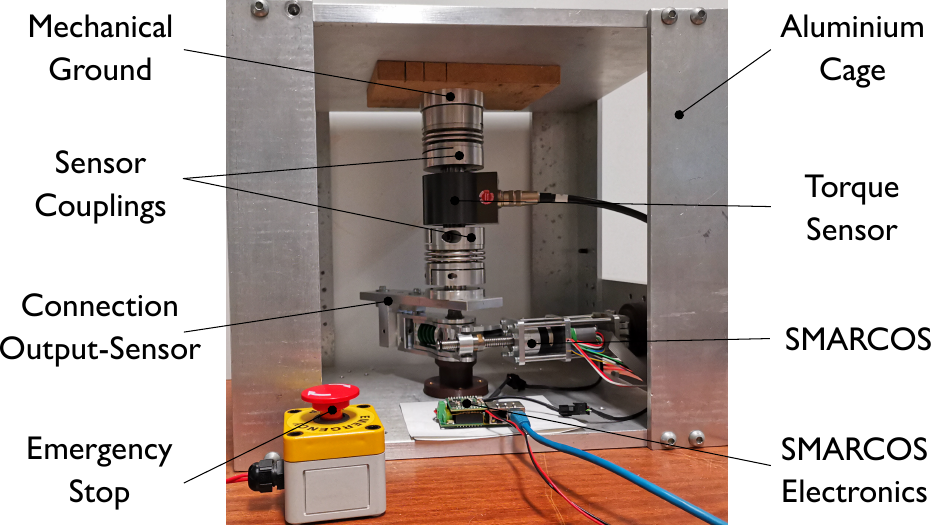
Figure 9. Test-bench used for the characterisation of the SMARCOS. For the quasi-static experiments, the output arm of the actuator is mechanically grounded to the aluminium cage through a torque sensor. The position encoders and the strain gauges are read by the SMARCOS electronics